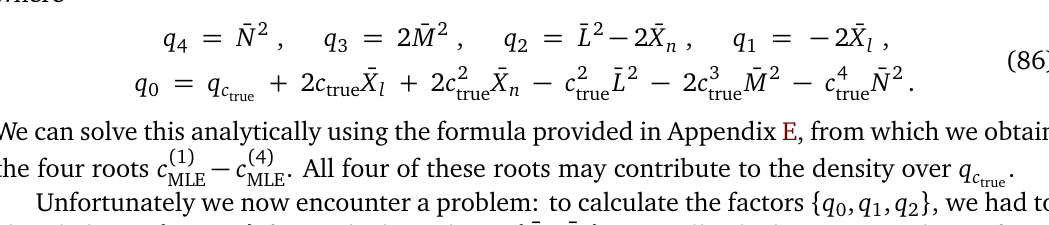
d q c true , which is obtained d ∆ 1